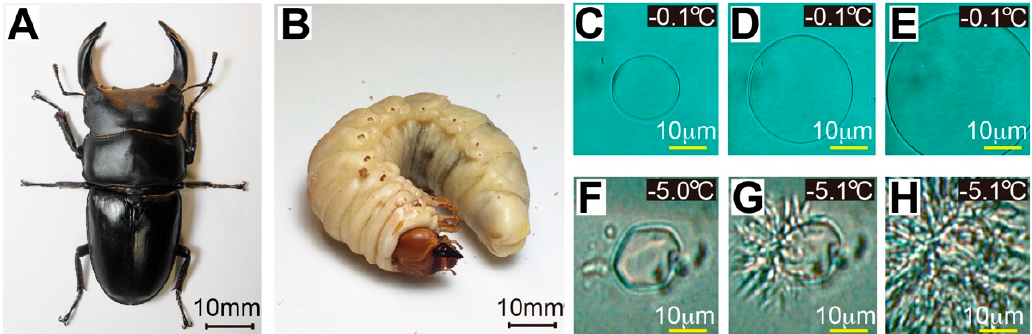
Figure 1. A stag beetle Dorcus hopei binodulosus ( Dhb ) and a bursting ice-crystal growth observed for its hemolymph at the freezing point. ( A ) An adult form of Dhb and ( B ) its final instar larva. The adult is uniquely equipped with a pair of antlers like a stag. ( C ) A photomicroscope image of a single ice crystal in ordinary supercooled water ( − 0.1 ◦ C), which shows a rounded disk-like morphology. ( D , E ) The disk expanded when the temperature was held, implying that there is no antifreeze substance. ( F ) A photomicroscope image of a single ice crystal prepared in larval hemolymph, which kept unchanged even if the temperature was changed between − 5.0 and 0 ◦ C because of the ice-binding of hyperactive AFPs. The hyperactive AFP-bound ice crystal is uniquely modified into a lemon-like shape. ( G ) Bursting ice growth occurred from a tip of the lemon crystal when it further lowered the temperature to freezing point ( − 5.1 ◦ C). ( H ) The bursting ice growth continues to show a vein-like pattern, which is also a known phenomenon for hyperactive AFPs.